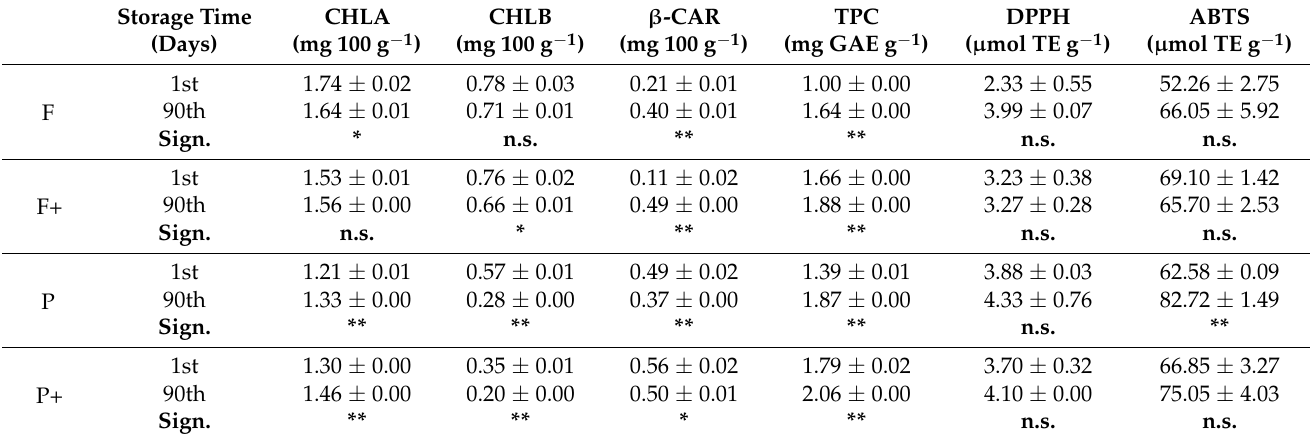
Table 4. Pigment and antioxidant parameter determination on pesto samples during